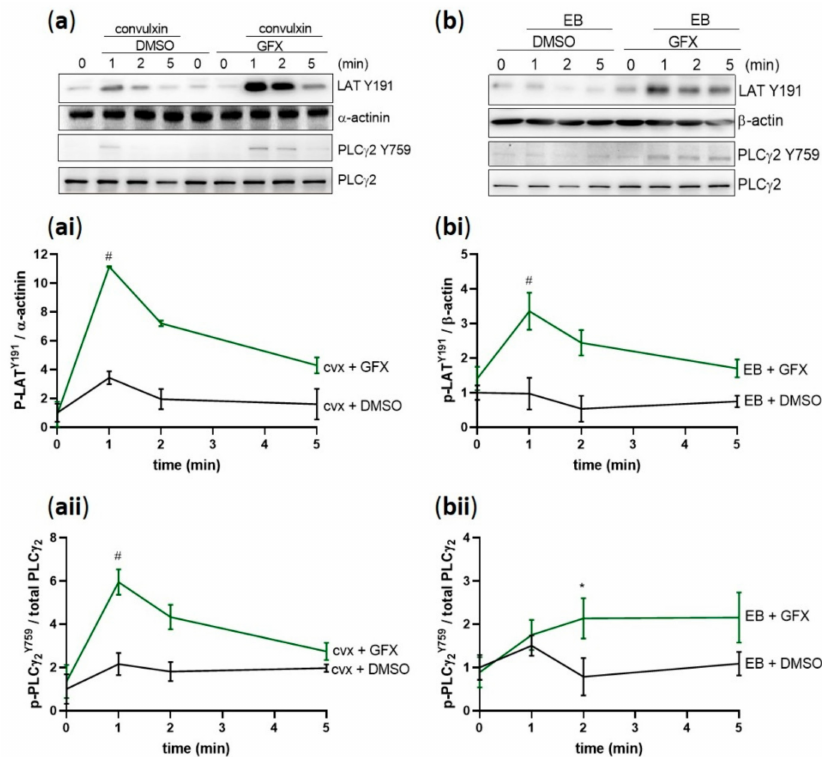
Figure 8. PKC inhibition induces hyperphosphorylation of Y-sites of Syk substrates. Washed human platelets were pre-incubated with DMSO (vehicle control) or with pan-PKC inhibitor GF109203X (5 µ M) at 37 ◦ C for 5 min prior to stimulation with ( a ) 50 ng / mL cvx or ( b ) 0.5% ( v / v ) EB. Platelet aggregation was stopped by adding Laemmli bu ff er after 1, 2, or 5 min of stimulation under stirring conditions. The kinetics of the phosphorylation of ( ai , bi ) LAT on Y191 and ( aii , bii ) PLC γ 2 on Y759 compared to the adequate loading control are represented as means ± SD from three independent experiments with platelets from three healthy donors. # p < 0.0001, * p < 0.05, DMSO-versus GFX-treated platelets at 1 min or 2 min in response to cvx or EB,